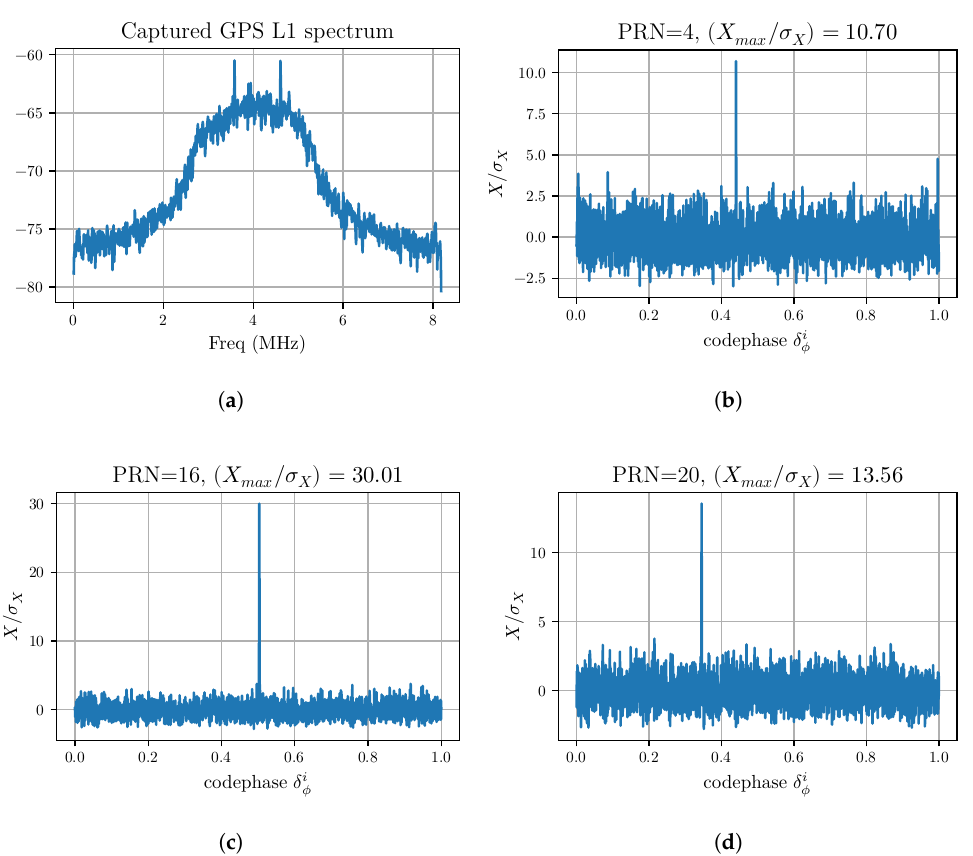
Figure 1. Some results showing typical correlation vs fractional-codephase for a sample of GPS L1 data, sampled at 16.368 MHz and down-sampled to 4.092 MHz. ( a ) baseband spectrum of the L1-band sampled GPS data. The center frequency is 1575.42 MHz downsampled to an intermediate frequency (IF) of 4.092 MHz. ( b ) correlation amplitude as a function of fractional codephase for the satellite with = 0.4398635; ( c ) correlation Pseudorandom Noise (PRN) code PRN = 4. The measured codephase is δ 4 φ amplitude as a function of fractional codephase for satellite with PRN = 16. The measured codephase = 0.503052; ( d ) correlation amplitude as a function of fractional codephase for satellite with is δ 16 φ = PRN = 20. The measured codephase is δ 20 φ